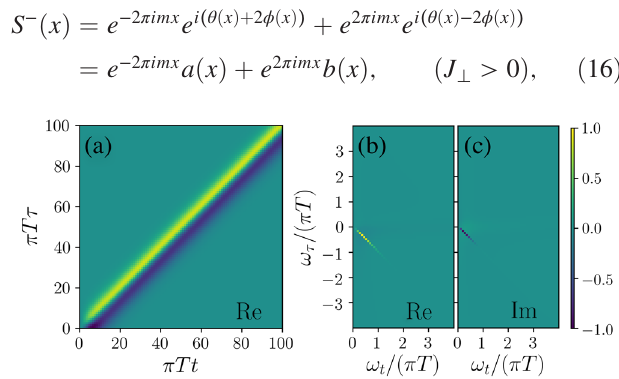
ð 3 Þ FIG. 3. (a) Nonlinear magnetic susceptibility χ þ −− þ of a ferromagnetic chain as function of π Tt and π T τ . The waiting time π Tt w ¼ 1 . The Luttinger parameter K ¼ 1 . The data are real numbers and are rescaled such that the maximum is 1. (b),(c) The real and imaginary parts of the two-dimensional spectrum obtained by Fourier transforming the data of (a). Only the first and fourth quadrants are shown. The data in the other two quadrants are obtained by complex conjugation; i.e., the real part (b) is invariant under the transformation ω τ → − ω τ ; ω t → − ω t , whereas the imaginary part (c) changes